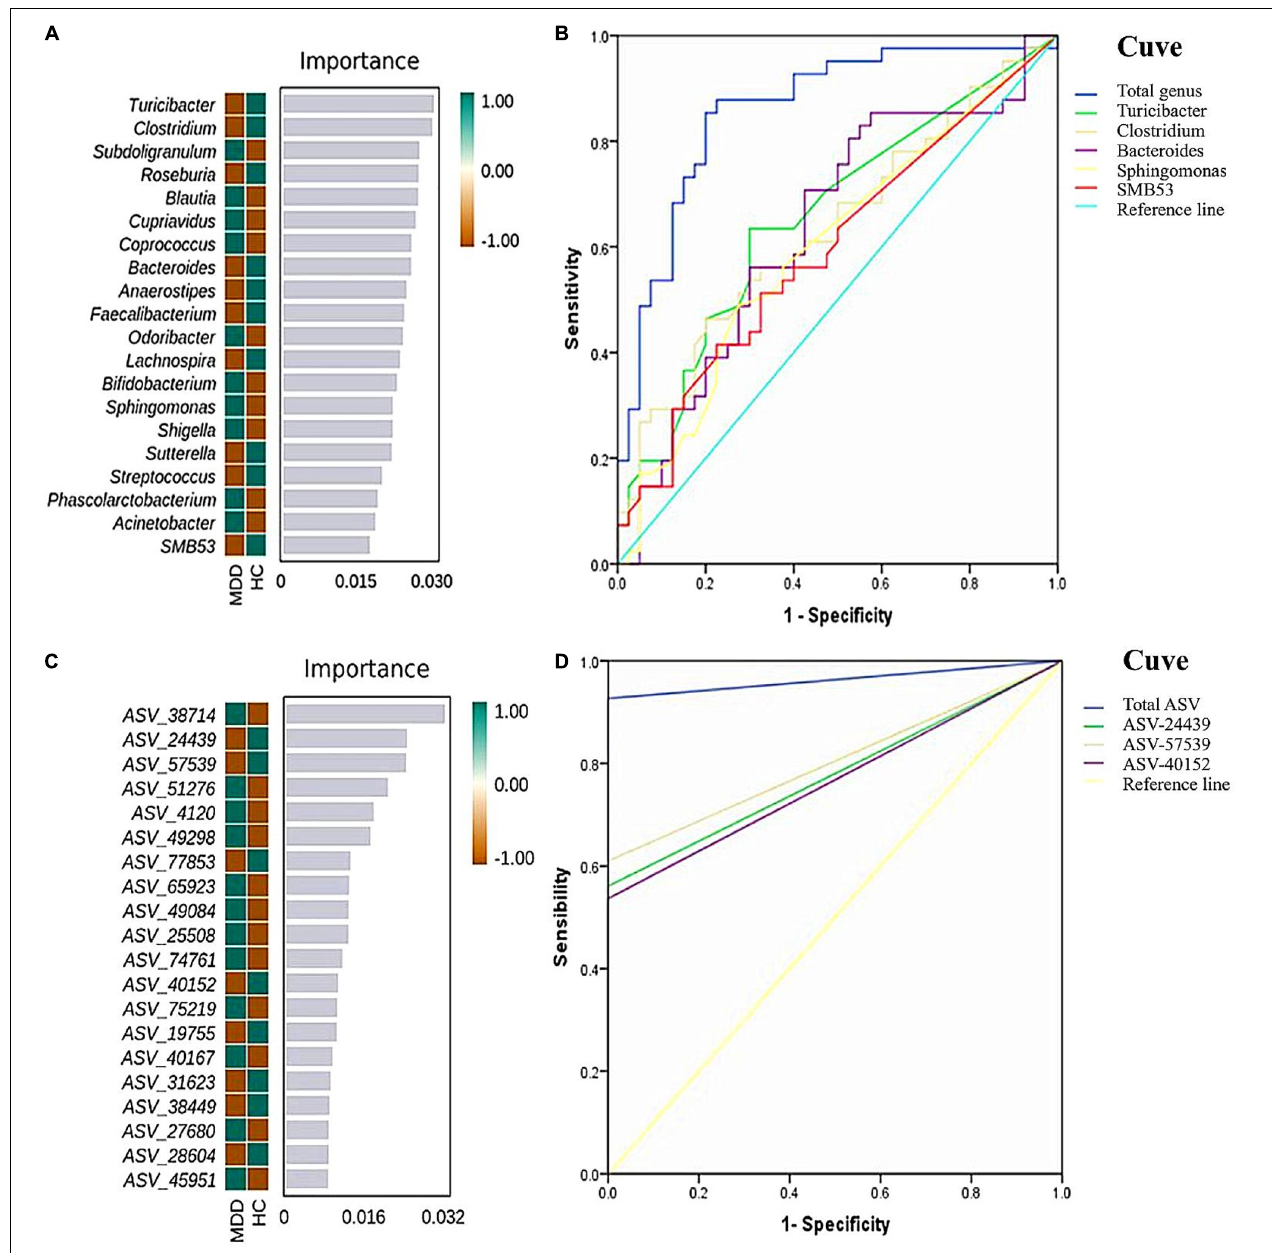
FIGURE 5 | Random forest (RF) classification for gut microbiota in the two groups. The important scores of the confirmed attributes are presented at the genus level (A) and ASVs level (C) , respectively. The receiver operating characteristic (ROC) curves were made by single and combined (total genus/ASVs) microorganism at the genus level (B) and ASVs level (D) ,